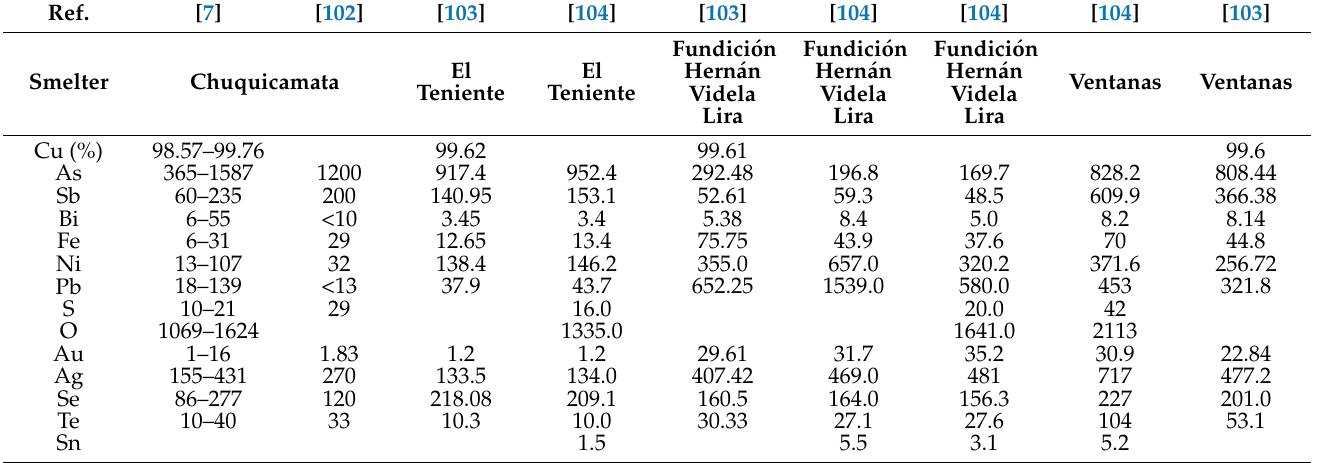
Table 7. Chemical composition (in ppm) of copper anodes from Chilean